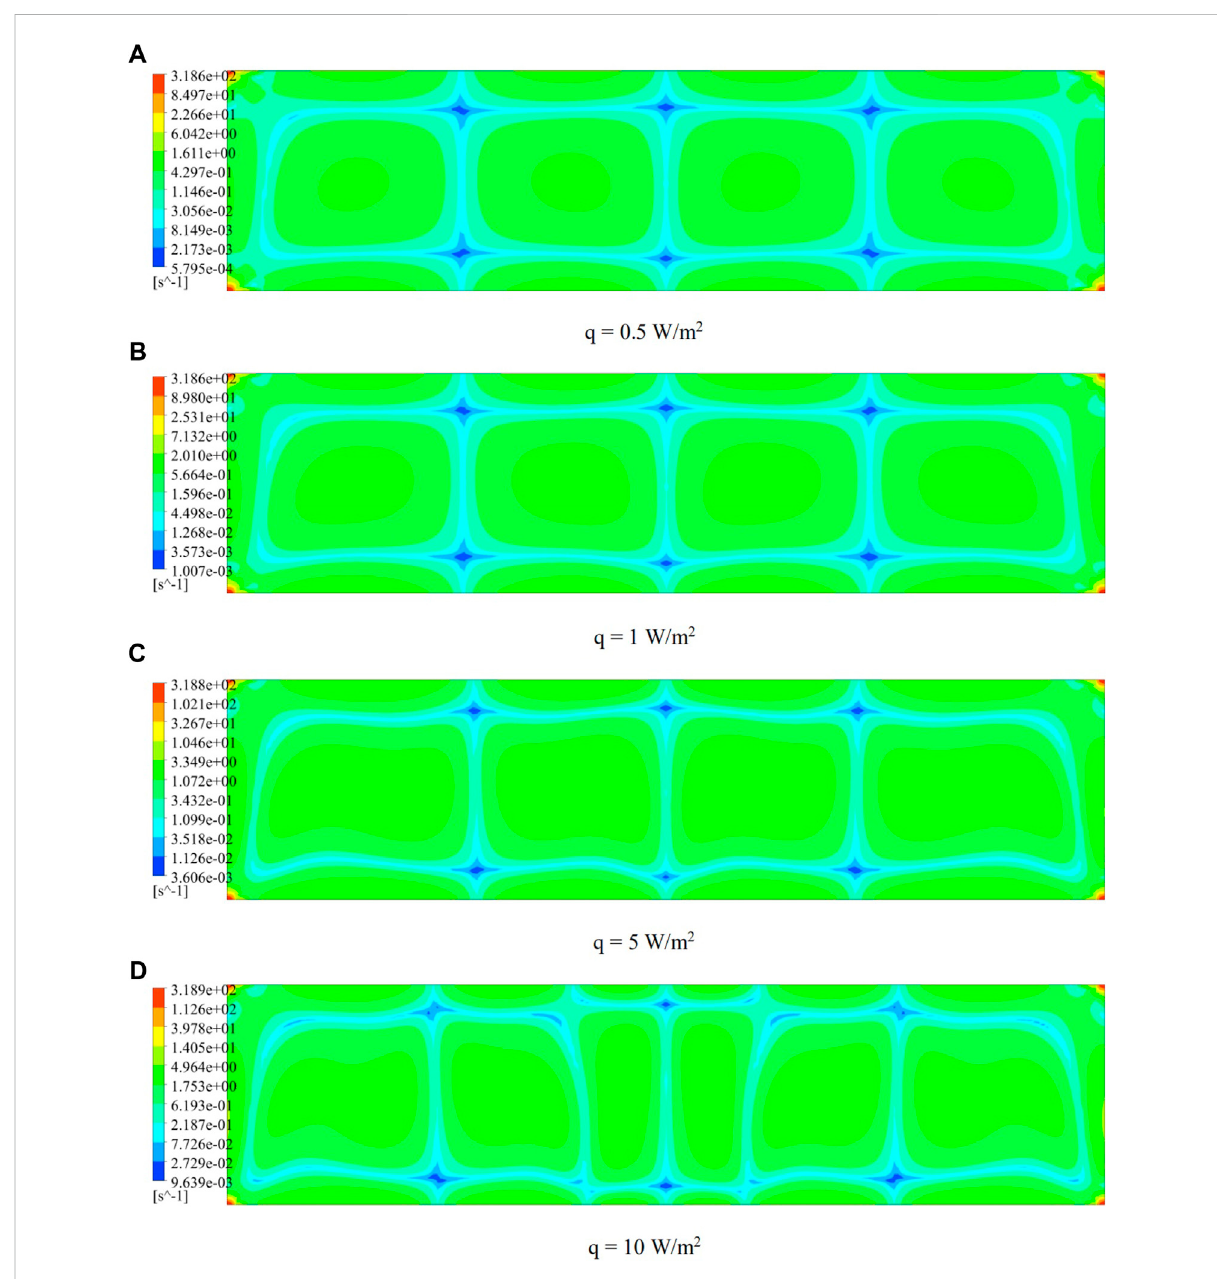
FIGURE 8 Comparisonofthevorticitycontourswithdifferentbottomheat fl uxesinasteadystate. (A) q=0.5 W/m 2 . (B) q=1 W/m 2 . (C) q=5 W/m 2 . (D) q= 10 W/m 2